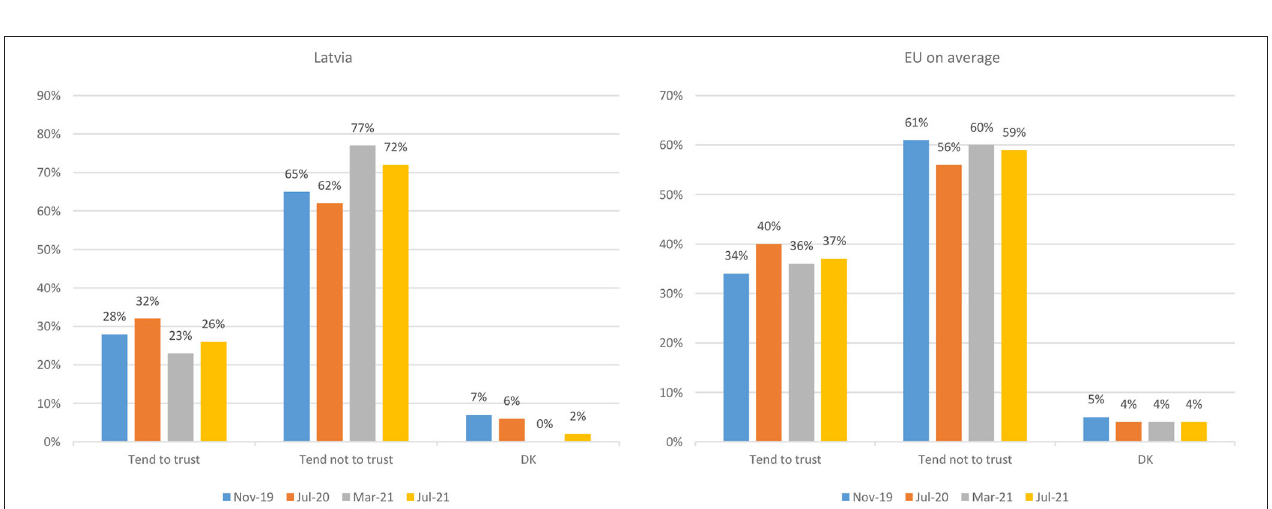
FIGURE 5 | Public trust in national government, percent of respondents, percent of respondents, 2019-2021 (9). Source: Standard Eurobarometer 92.3, 93.1, 94.3, 95.3.